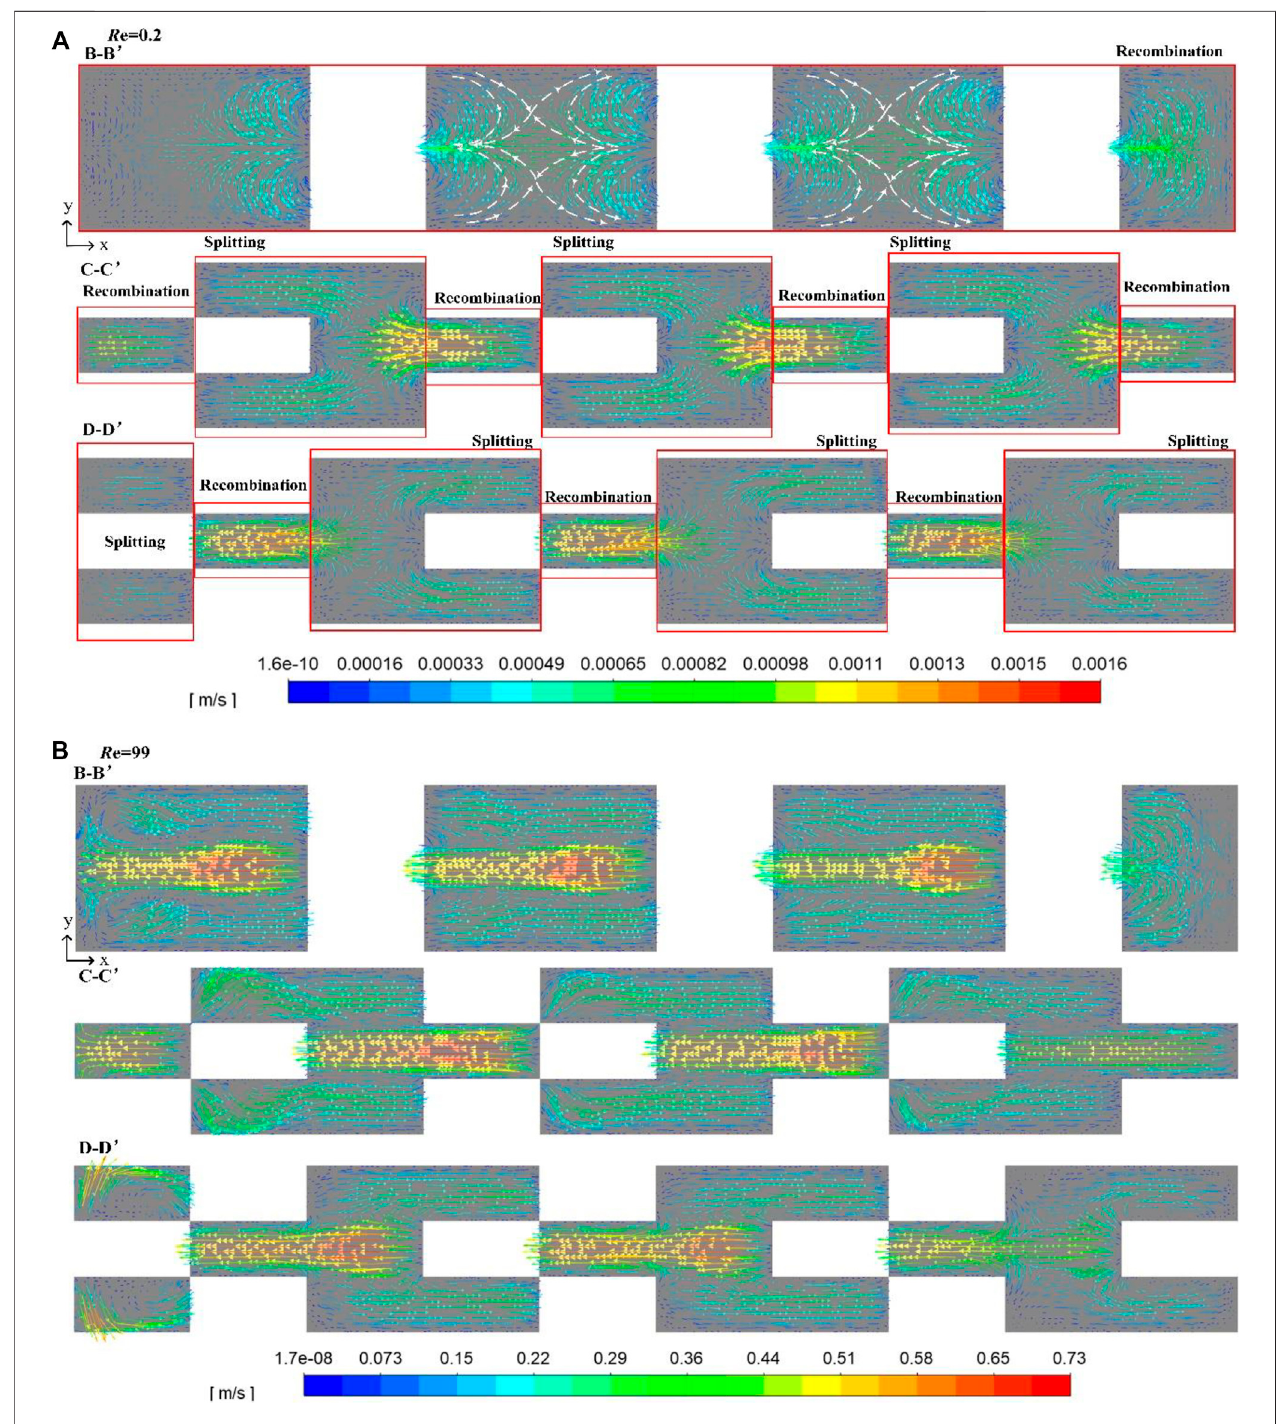
FIGURE 7 | Velocity vectors in the microreactor with three-layer inserts on x-y planes: (A) R e (cid:1) 0.2 and (B) R e (cid:1) 99.